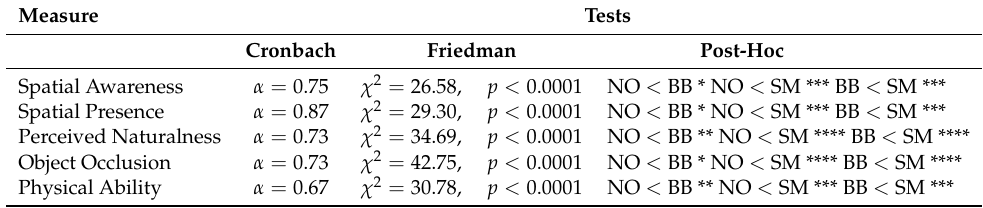
Figure 11. Results of subjective measures on three conditions: No occlusion (NO), Bounding box (BB), and Silhouette mesh (SM). Statistical significance levels: * p < 0.05, ** p < 0.01, *** p < 0.001, and **** p < 0.0001. Table 3. Summary of statistical analysis